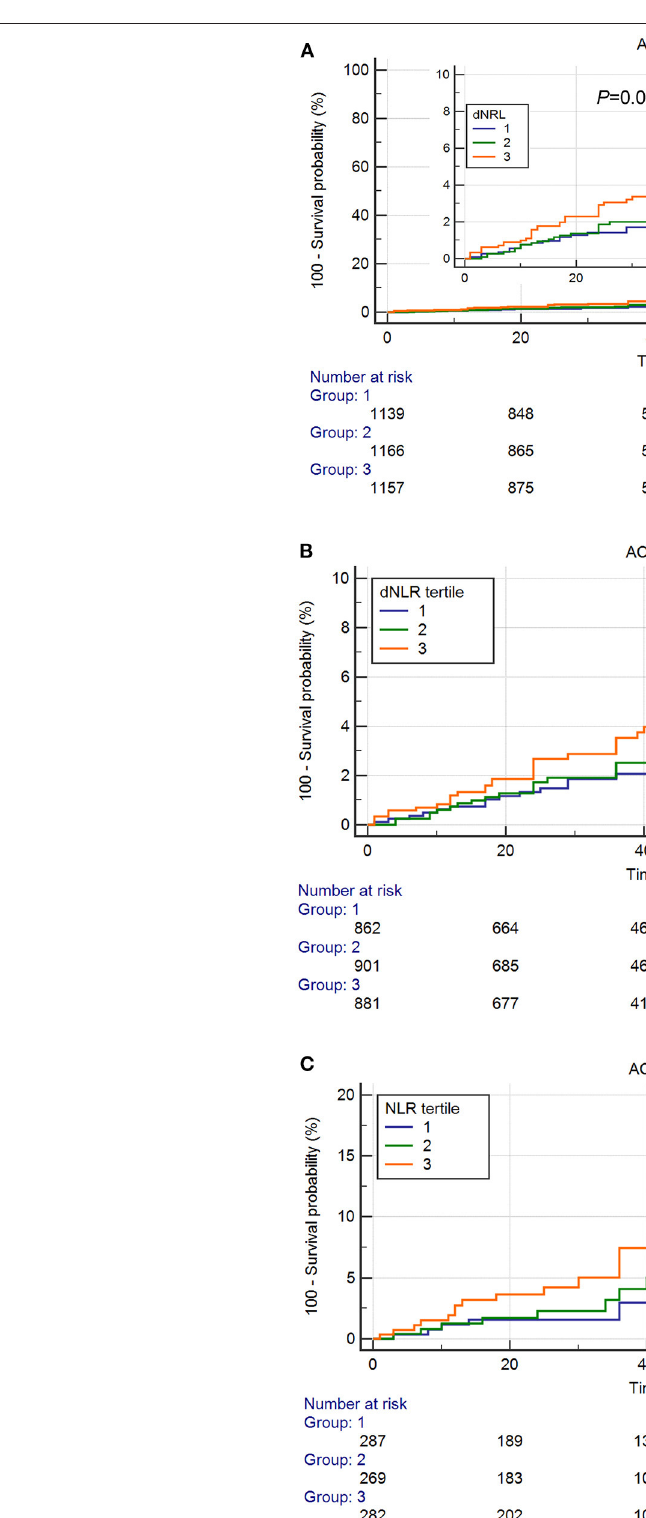
Frontiers in Cardiovascular Medicine |